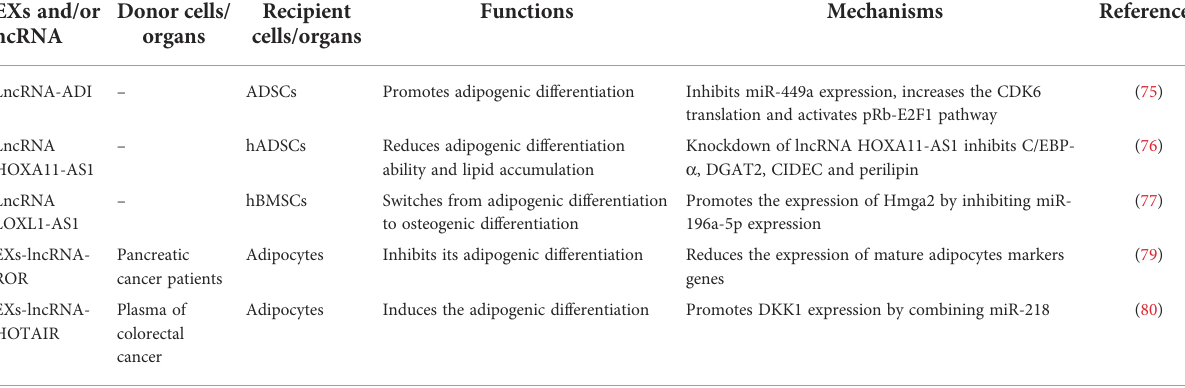
TABLE 3 EXs and/or lncRNAs regulate adipogenic differentiation.